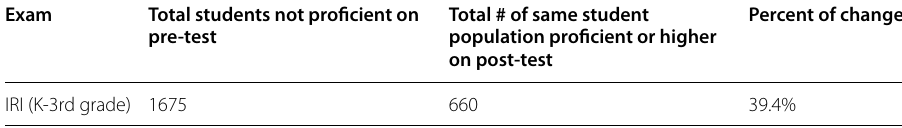
Table 3 Percentages of 21st CCLC students showing growth pre to post testing Exam Total students not proficient on Total # of same student Percent of change pre-test population proficient or higher on post-test IRI (K-3rd grade) 1675 660